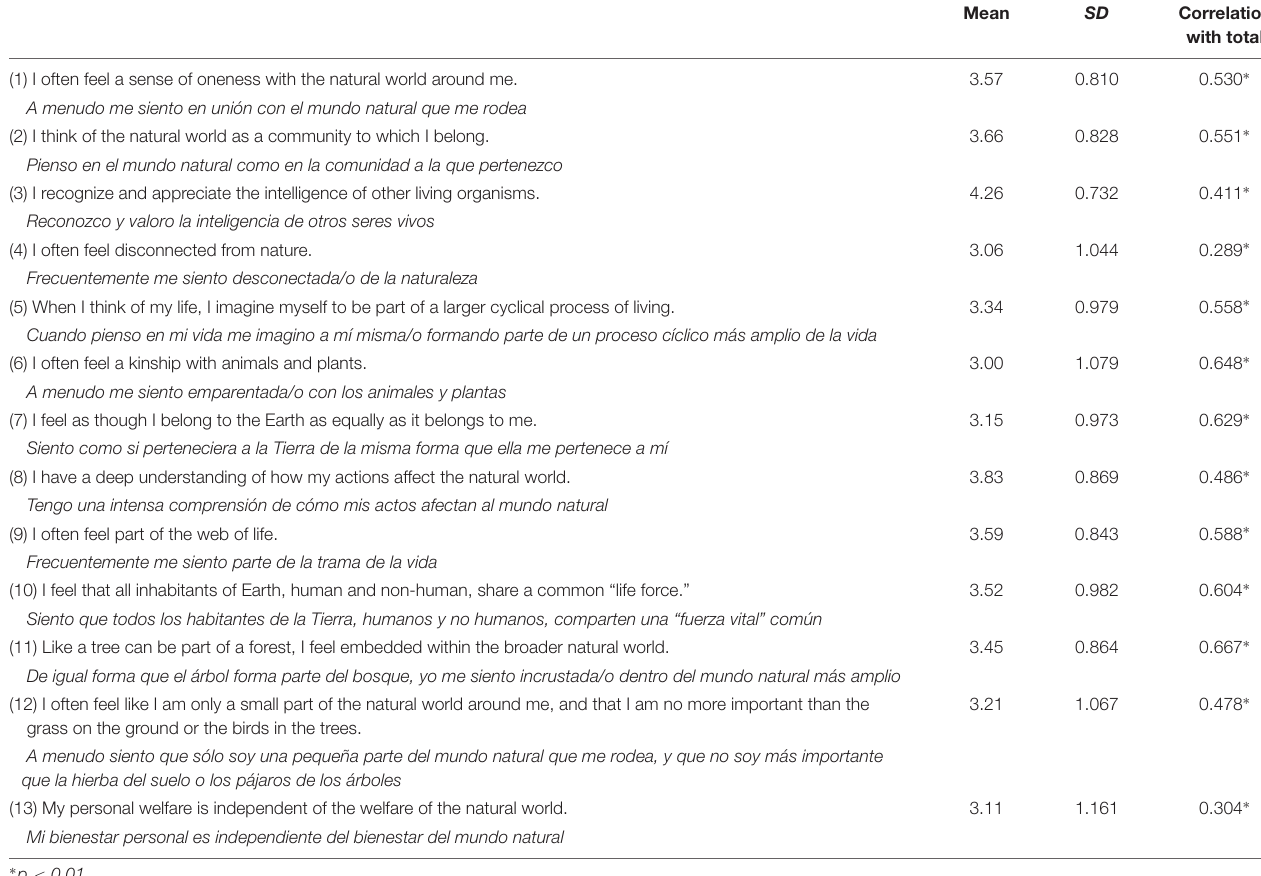
TABLE 1 | Descriptive statistics of Connectedness to Nature Scale (CNS) items.